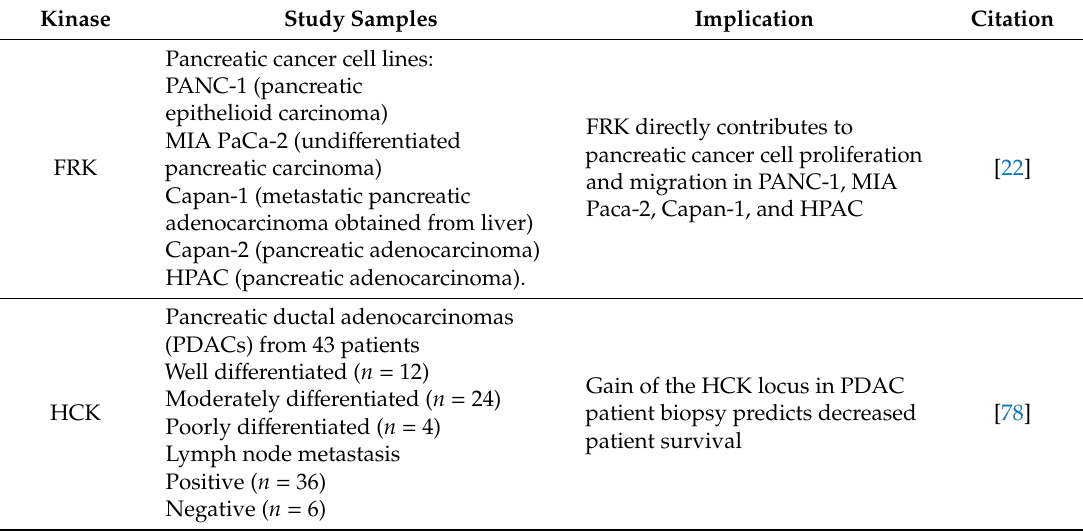
Table 1. Summary table of selected kinases in pancreatic